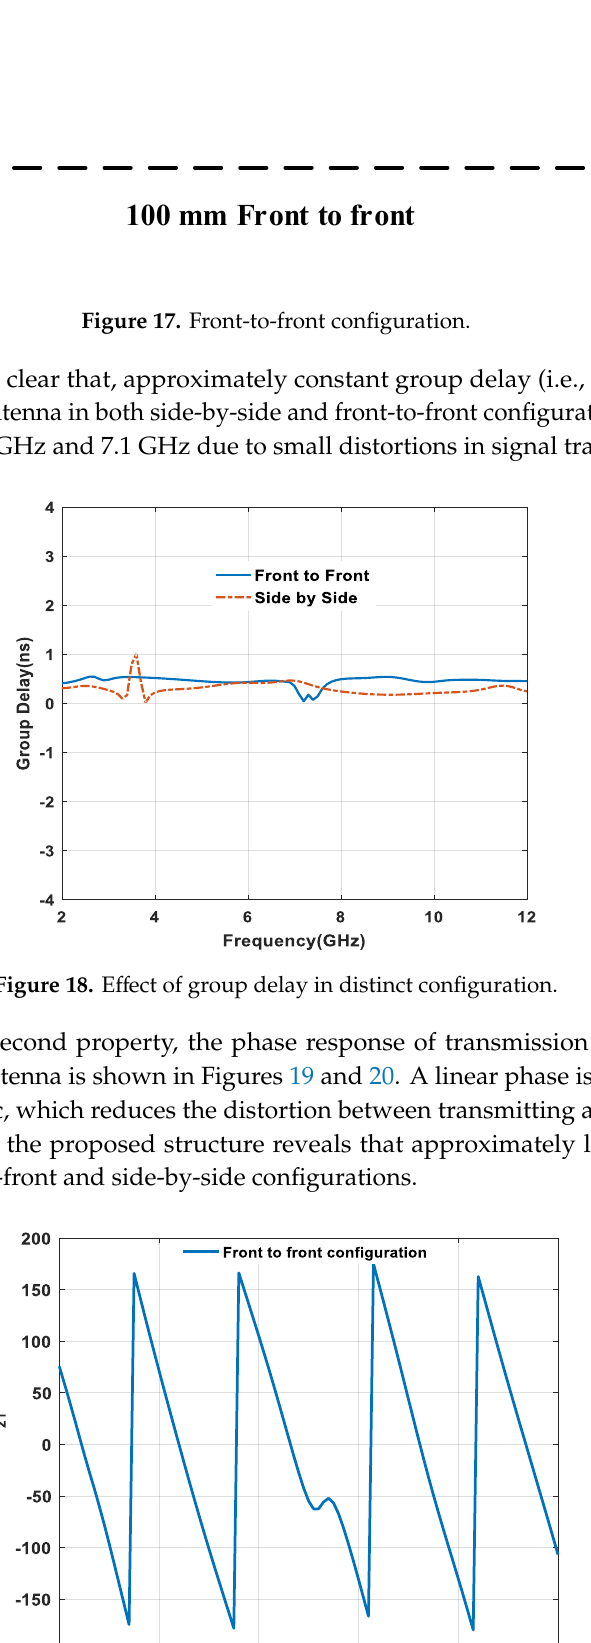
Figure 19. Phase variation effect of s 21 in front-to-front.